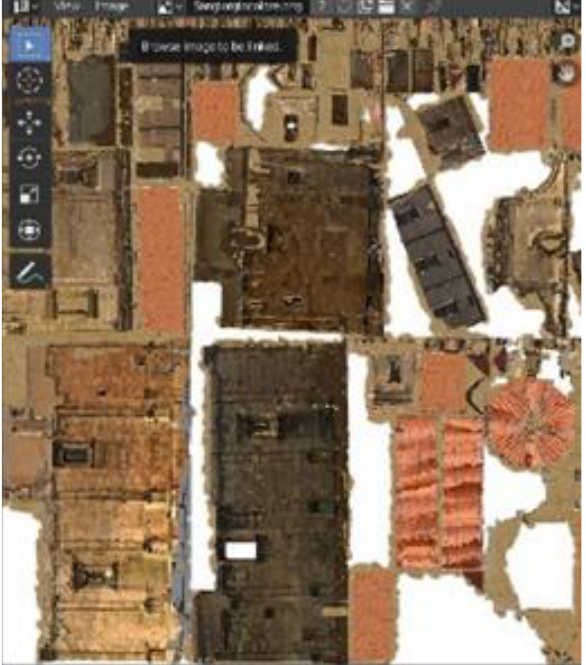
Figure 9. UV mapping operation on the texturization of the 3D model in the second solution.